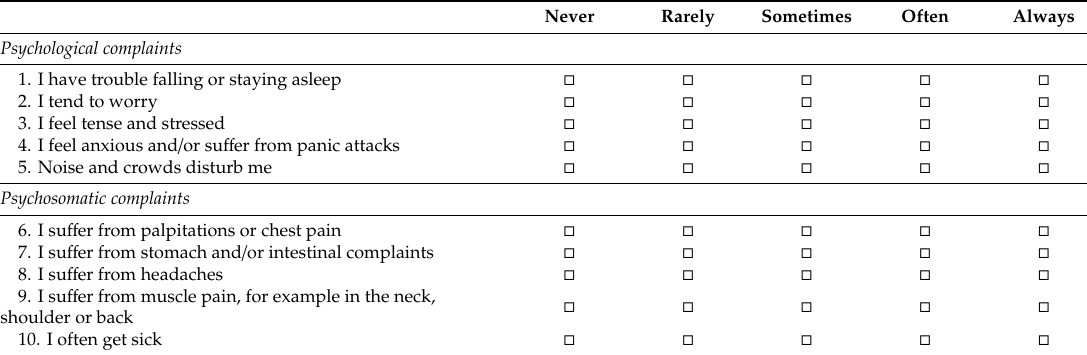
Table A3. Secondary Symptoms